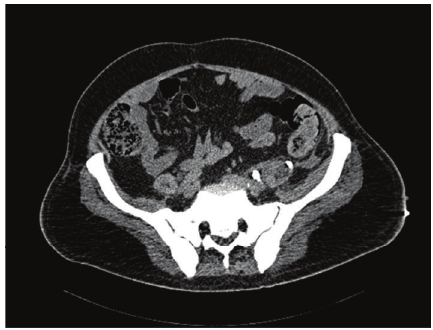
Figure 5: Abdominal CT scan: absence of the urinoma.